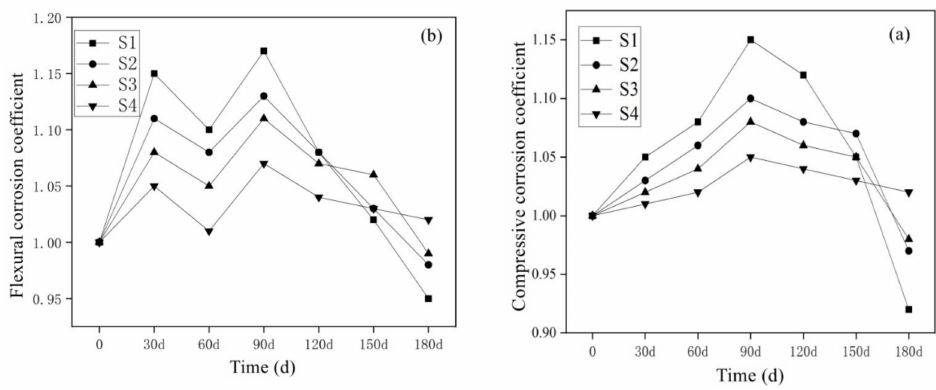
Figure 9. Compressive ( a ) and flexural ( b ) corrosion resistance coefficients of MSWI mortars under sodium sulfate semi-immersion condition.